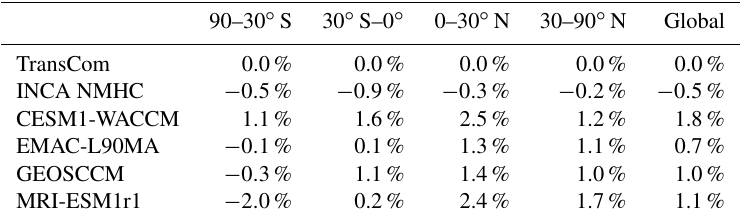
Table 4. Global and latitudinal percentage changes in CH 4 -reaction-weighted [OH] from 2000–2002 to